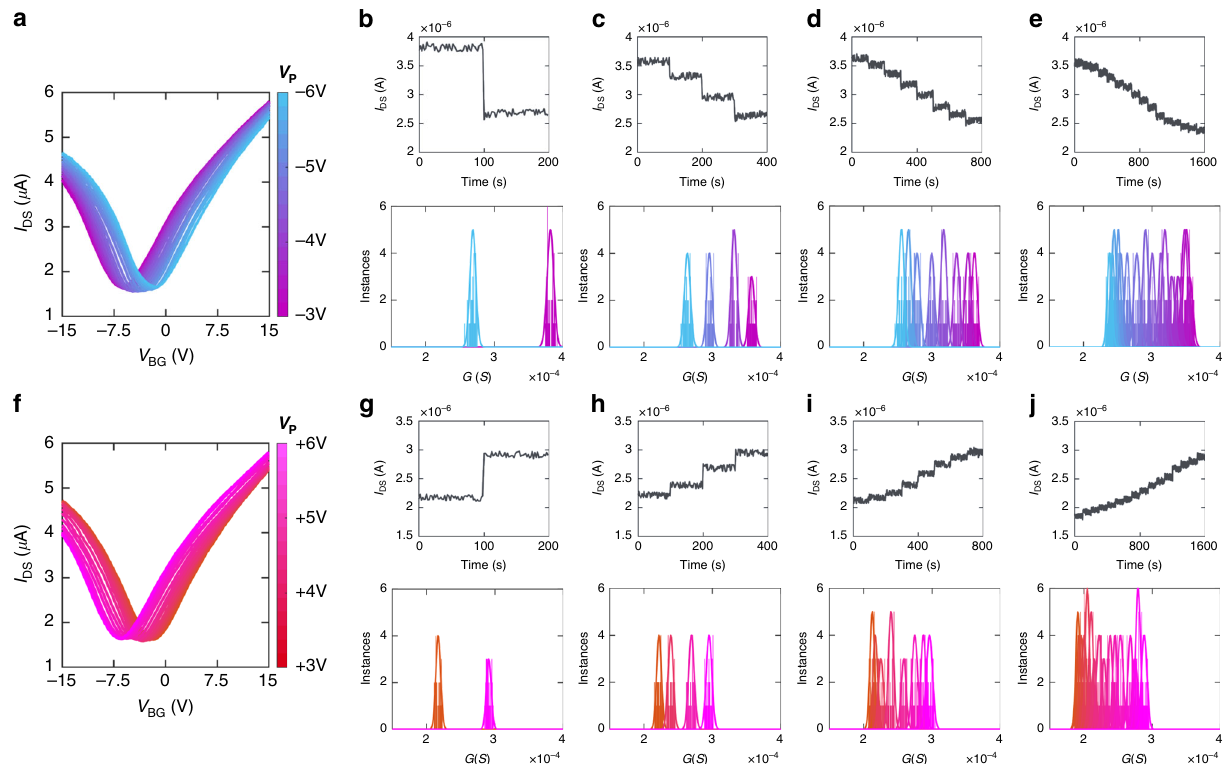
Fig. 2 Memory levels, memory ratio, and memory retention of graphene memristors. a Transfer characteristics of a GFET when negative write voltage pulses of duration 1 s with increasing magnitude are applied, starting at − 3 V and increasing to − 6 V in steps of − 0.2 V. The GFET characteristics clearly show a monotonic transition from n-type to ambipolar characteristics. Prior to the application of these write pulses, the GFET was set to n-type characteristics via the application of a positive V DS pulse of magnitude 6 V. Clearly, multiple (>2) memory levels (conductance states) are achieved in graphene memristors. Memory ratio and memory retention, measured for a total duration of 100 s at V BG = 0 V, for a graphene memristor programmed into ( b ) 2, ( c ) 4, ( d ) 8, and ( e ) 16 memory levels using different write pulse ( V DS ) step sizes, each of duration 1 s. Accompanying histograms display the conductance distributions for each programming con fi guration. The maximum write pulse magnitude was restricted to ≤ 5 V in order to ensure high switching endurance. Signi fi cant memory ratio is achieved when V DS step size is 2 V. However, as the number of memory level is increased by decreasing V DS step size to 0.5 V, 0.25 V, and 0.125 V, respectively, the memory ratio diminishes, reducing the distinguishability between the conductance states. f Transfer characteristics of an ambipolar GFET when positive write voltage pulses of duration 1 s with increasing magnitude are applied, starting at 3 V and increasing to 6 V in steps of 0.2 V. The GFET returns to n-type characteristics. Memory ratio, memory retention, and corresponding histograms of conductance distributions for the same graphene memristor programmed into ( g ) 2, ( h ) 4, ( i ) 8, and ( j ) 16 memory levels. These results indicate the ability to con fi gure the GFET in precise conductance states, change it in either direction (i.e., higher conductance to lower or vice versa), and return it to previous conductance states by applying voltage pulses of opposite